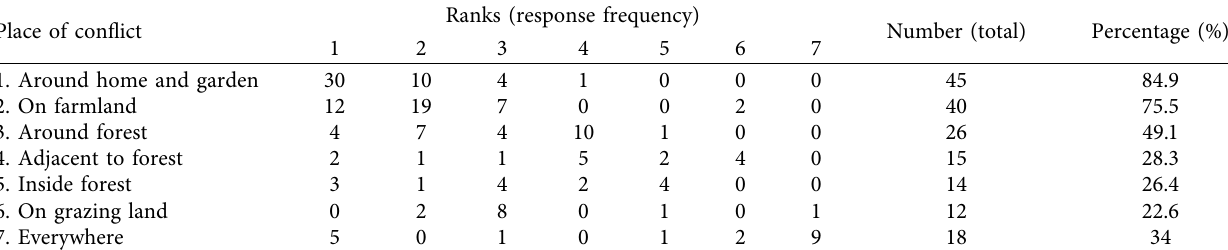
Table 4: Places of occurrence of conflict between humans and wild